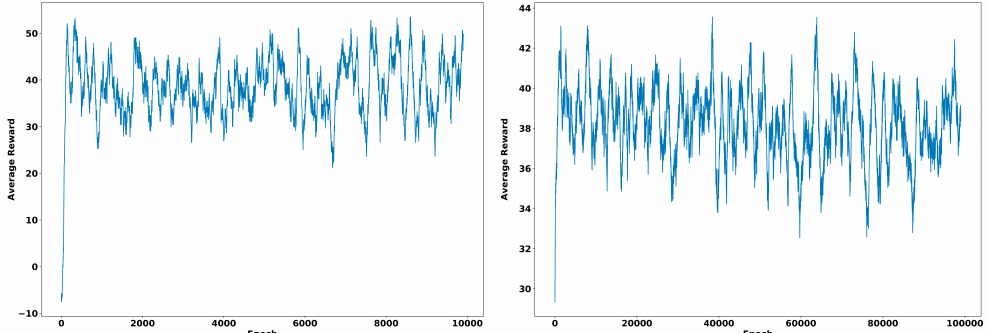
Figure 5. Average reward after ( left ) 10,000 epochs and ( right ) 100,000 epochs training of a camera agent to reach a specific location through